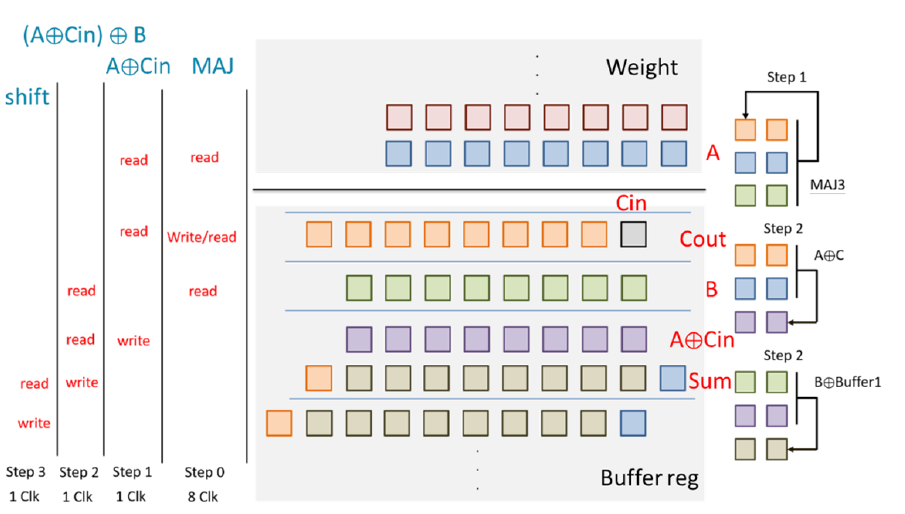
Figure 9. Steps of the shift adder.